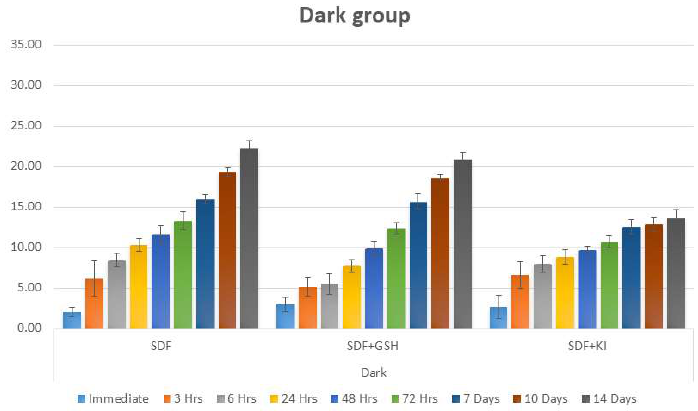
Figure 4. Bar chart showing mean ∆ E for different tested groups for dentin substrate within each time interval under dark conditions.